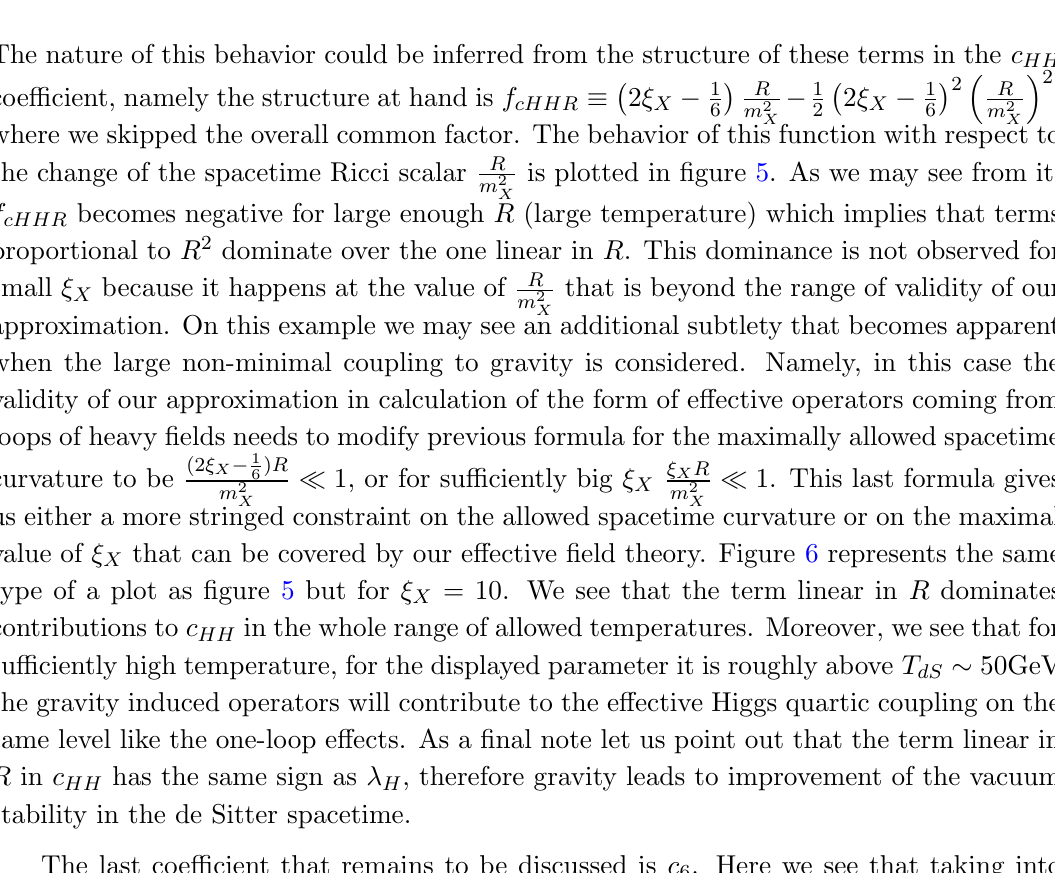
Figure 5 . The function f cHHR = non-minimal coupling (cid:24) X . m X was held (cid:12)xed at 10TeV. The maximally allowed curvature ful(cid:12)lls R (cid:28) m 2 X